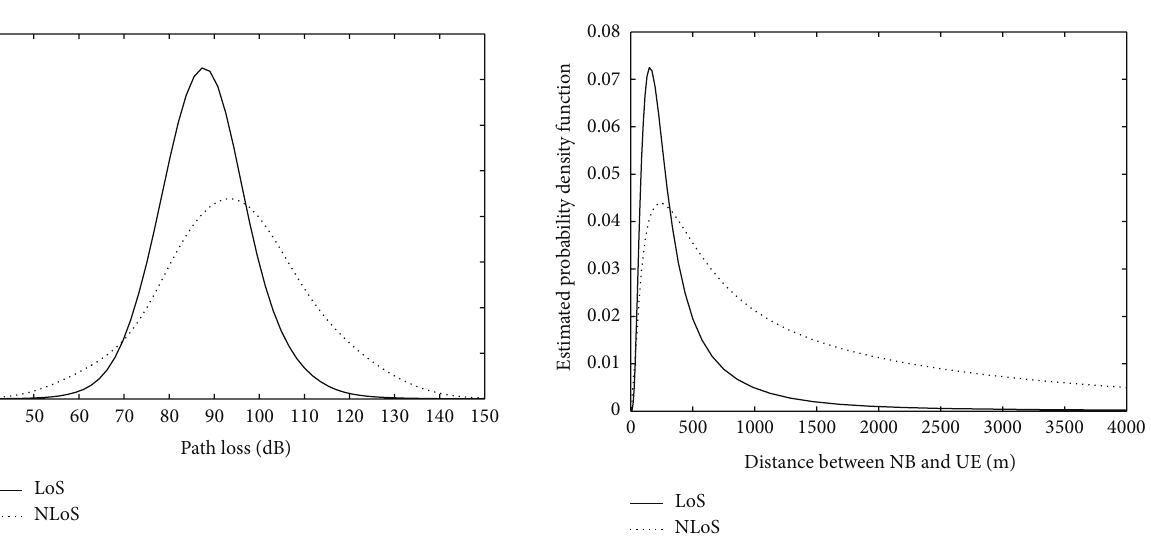
Figure 10: The empirical pdfs of the distance between the NB and the UE in LoS and NLoS scenarios.